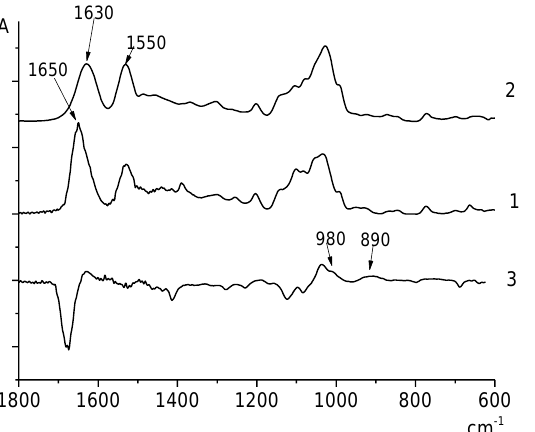
Figure 4. FTIR spectra of MAG homopolymer (1), MAG-VPA copolymer (2) (Experiment 3, Table 1), the difference spectrum (3).